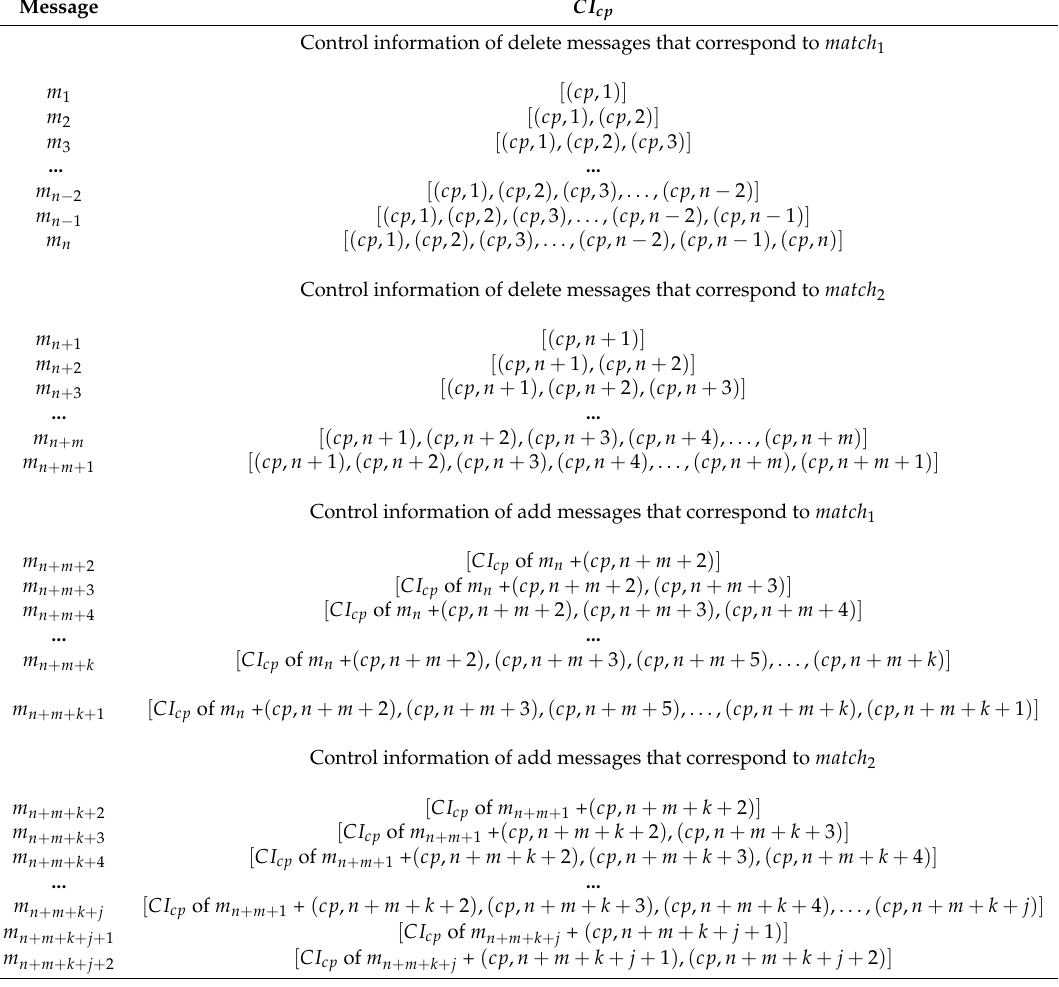
Control information of update messages generated on the cp for future message corresponding to match 1 and match 2